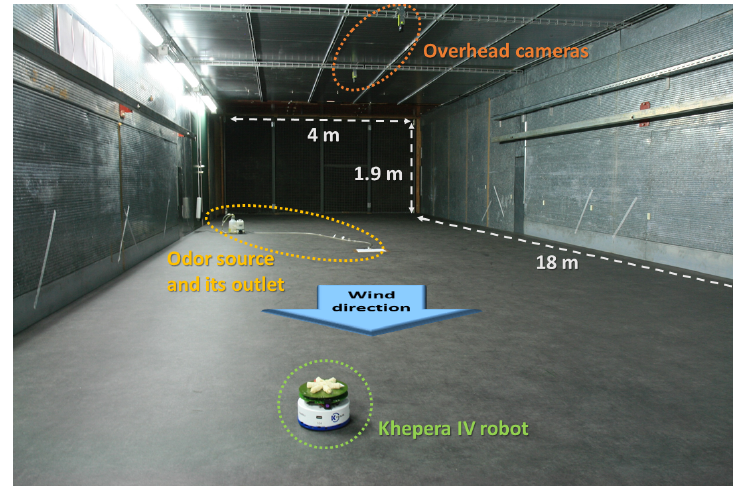
Figure 8. A view of the wind tunnel environment, along with a Khepera IV robot, the emulated odor source as well as the overhead